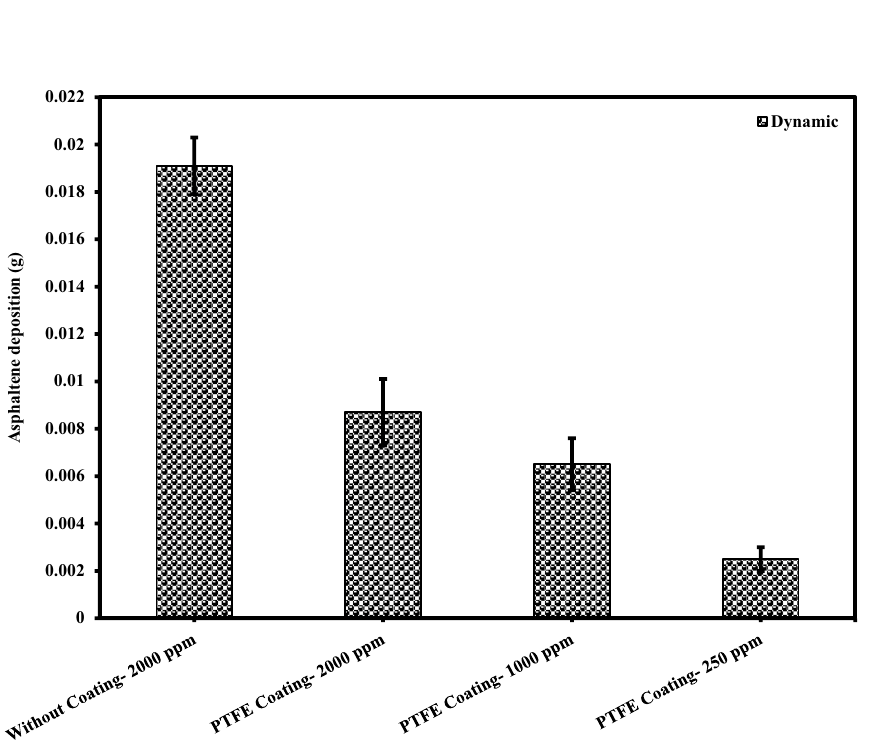
Figure 8. Comparison of coated and uncoated electrodes based on the amount of deposition at different asphaltene concentrations in dynamic state at ambient pressure and temperature (The amount of asphaltene deposition were reported at the end of 300 s